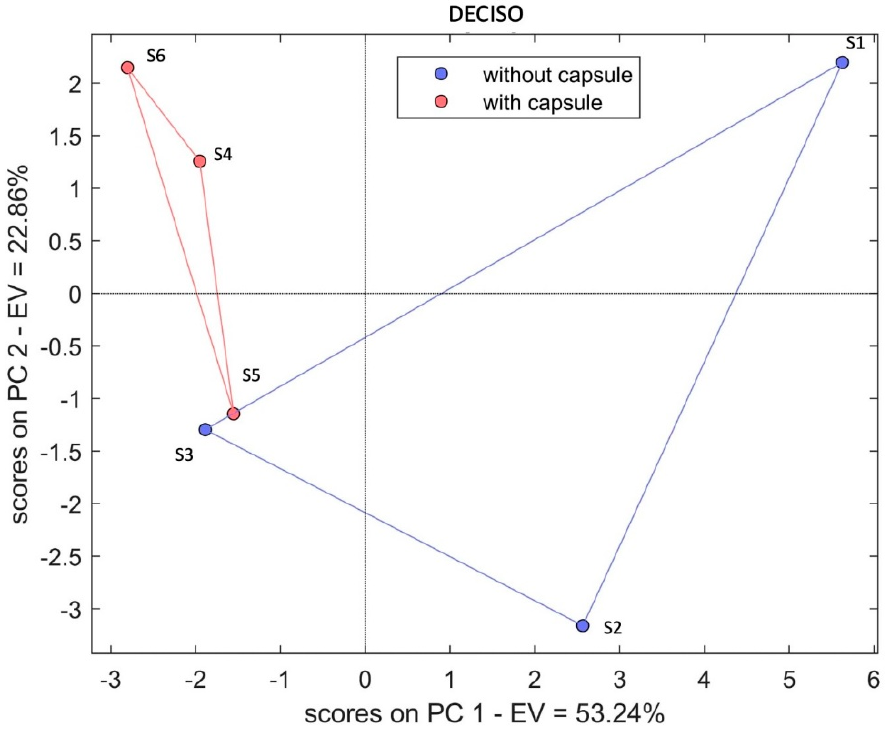
Figure 6. PCA score showing the comparison between volatile spectra compound of Deciso coffee “with capsule” and “without capsule” exhibiting an EV (explained variance) = 76.10%.